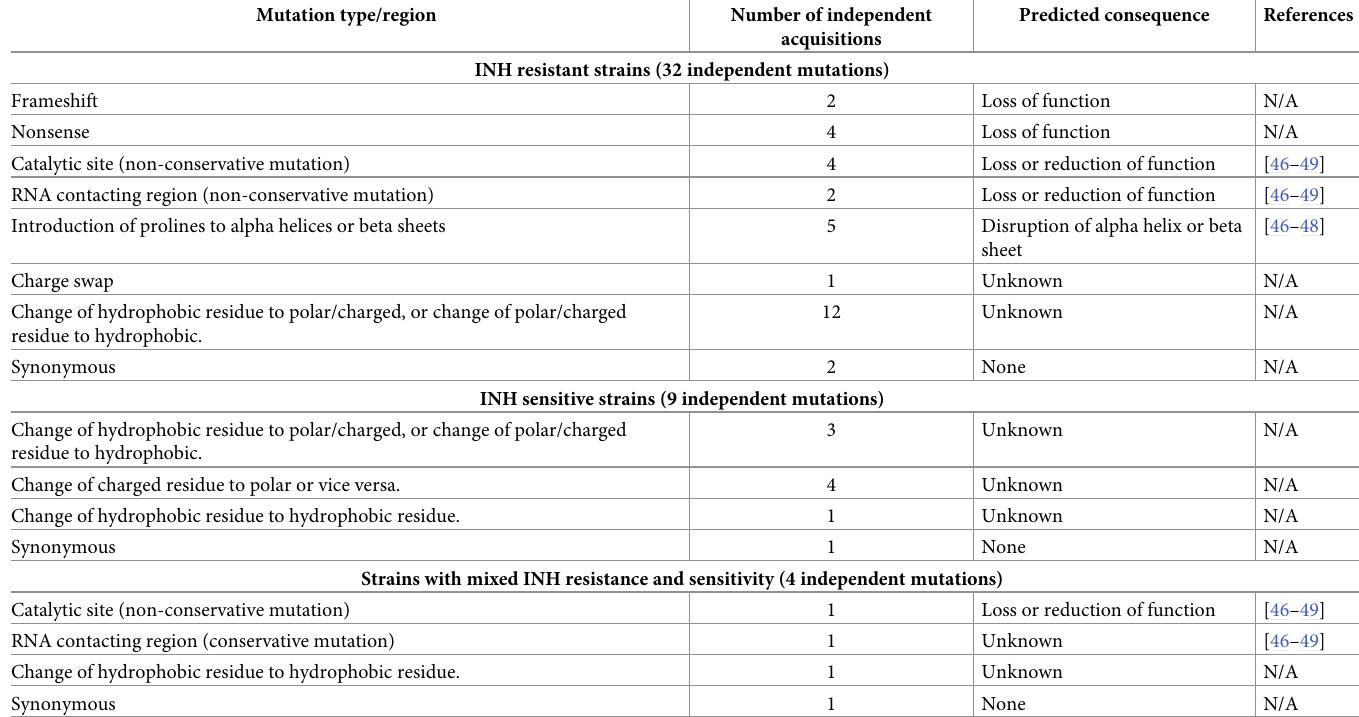
Table 1. Summary of rnj mutations identified in clinical strains of M . tuberculosis and their predicted consequences. Mutation